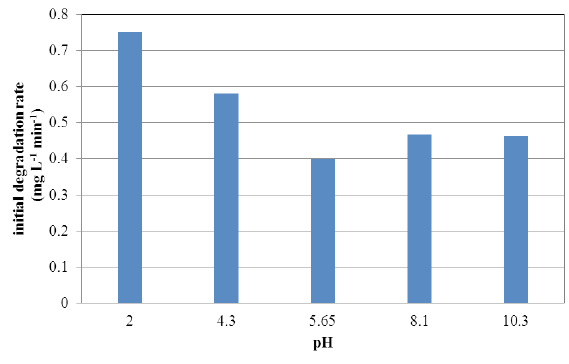
Figure 3: Initial degradation rate at various pH values (treated volume 500 mL; initial dye concentration: 20 mg L -1 ). No TiO